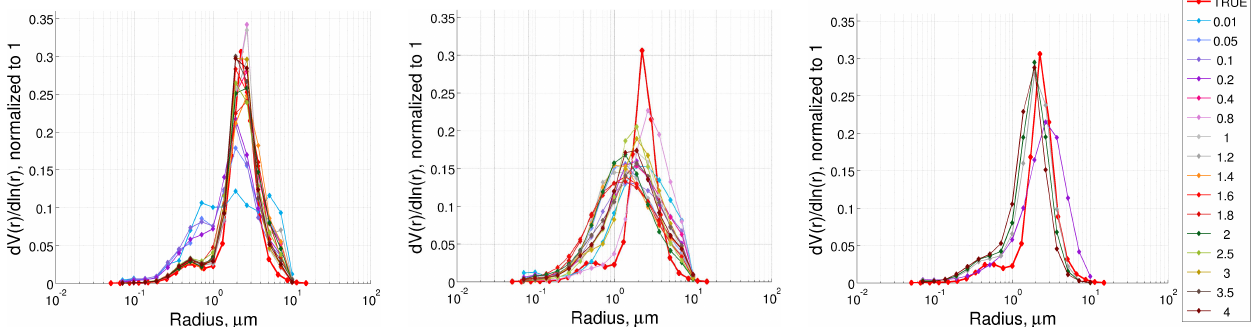
Fig. 13. Retrieval of desert dust size distribution over Banizoumbou for 16 different aerosol loadings from τ (0.44µm)=0.01 to 4.0: (left panel) single pixel retrieval with no noise added; (center panel) single-pixel retrieval, with the random noise added; (right panel) multi-pixel retrieval with the random noise